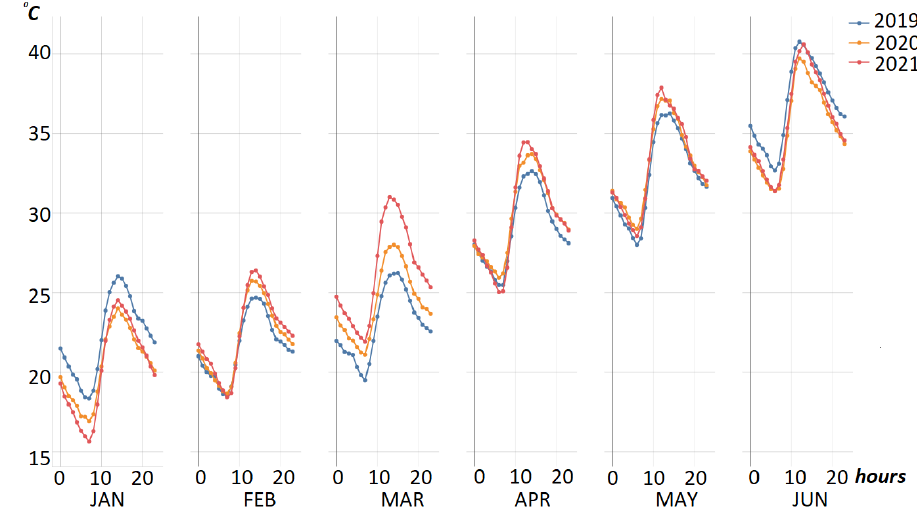
Figure 8. Mean hourly temperature for the first 6 months over 3 Years.